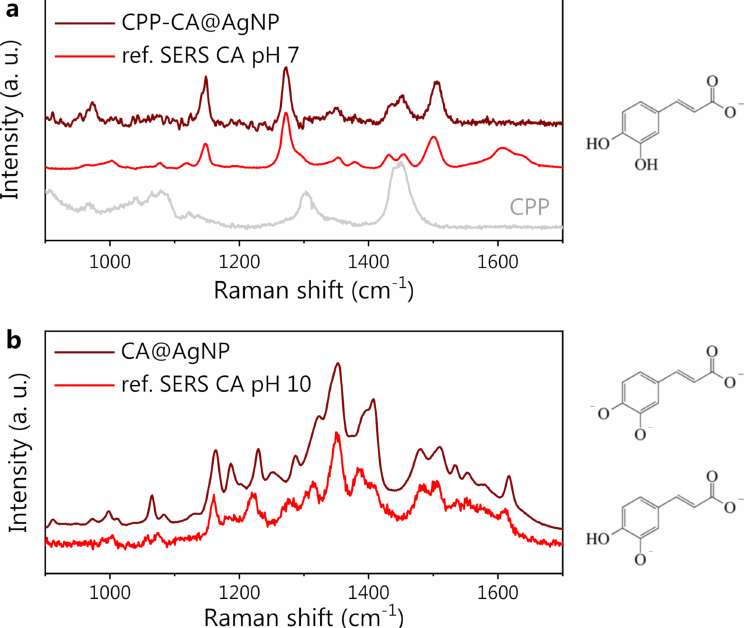
Figure 4. ( a ) From bottom to top: CPP SERS reference spectrum (gray), CA SERS reference spectrum at pH 7 (red), and SERS spectrum of CA-synthesized AgNP in the presence of CPP (CPP-CA@AgNPs, wine). ( b ) From bottom to top: CA SERS reference spectrum at pH 10 (red), and SERS spectrum of CA-synthesized AgNP in the absence of CPP (CA@AgNPs, wine). On the right side of the figure, the CA forms (protonated/deprotonated/doubly deprotonated) expected at neutral (7, top) and highly alkaline (10, bottom) pH are